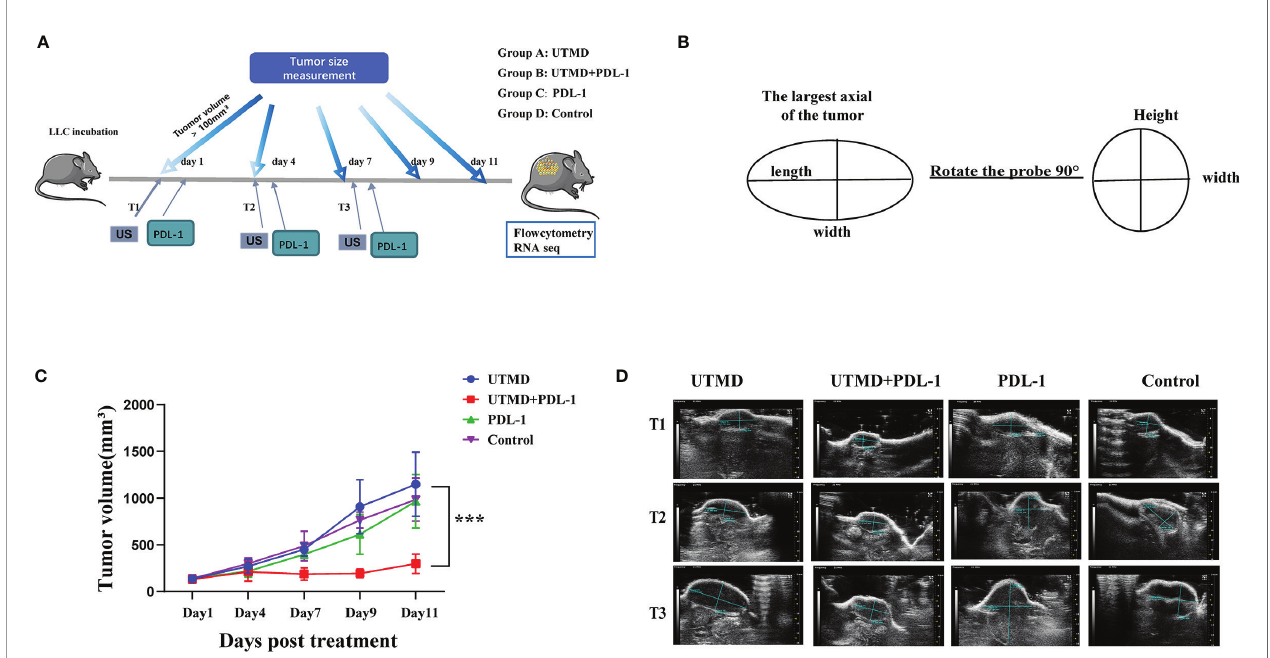
FIGURE 4 | Tumor progression inhibited by the combination of ultrasound-targeted microbubble destruction (UTMD) and PDL-1 blockade therapy. (A) The timeline of treatments and tumor measurements with different group settings. Groups A and B received the UTMD treatment. Groups B and C received PDL-1 blockade therapy. (B) The illustration of tumor volume measurement with two-dimensional ultrasound. (C) The curve line of tumor growth in a different group setting (n = 5). (D) The representative two-dimensional ultrasound images of tumor size in each group by the time of the fi rst (T1), second (T2), and third (T3) treatments. ***P <